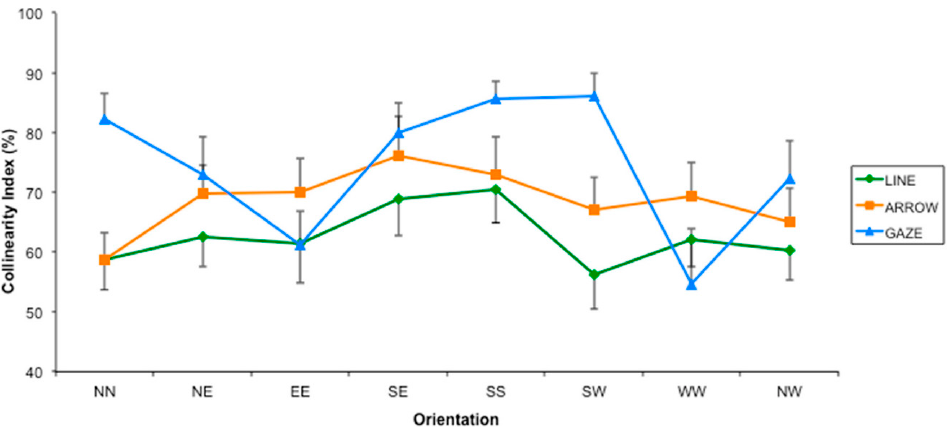
Figure 5. Collinearity Index (indicating the percentage of responses towards the collinear direction) for the three types of stimuli as a function of the eight possible orientations (Experiment 1). Error bars indicate the Standard Error. North-North, North-East, East-East, South-East, South-South, South-West, West-West, North-West (NN, NE, EE, SE, SS, SW, WW, NW, respectively). In particular, if we compare the patterns of responses of gaze and arrows, the proportion of responses towards the collinear is higher for gaze when the direction indicated by the orientation is on the vertical axes, whereas it is higher for arrows when the direction indicated by the orientation is